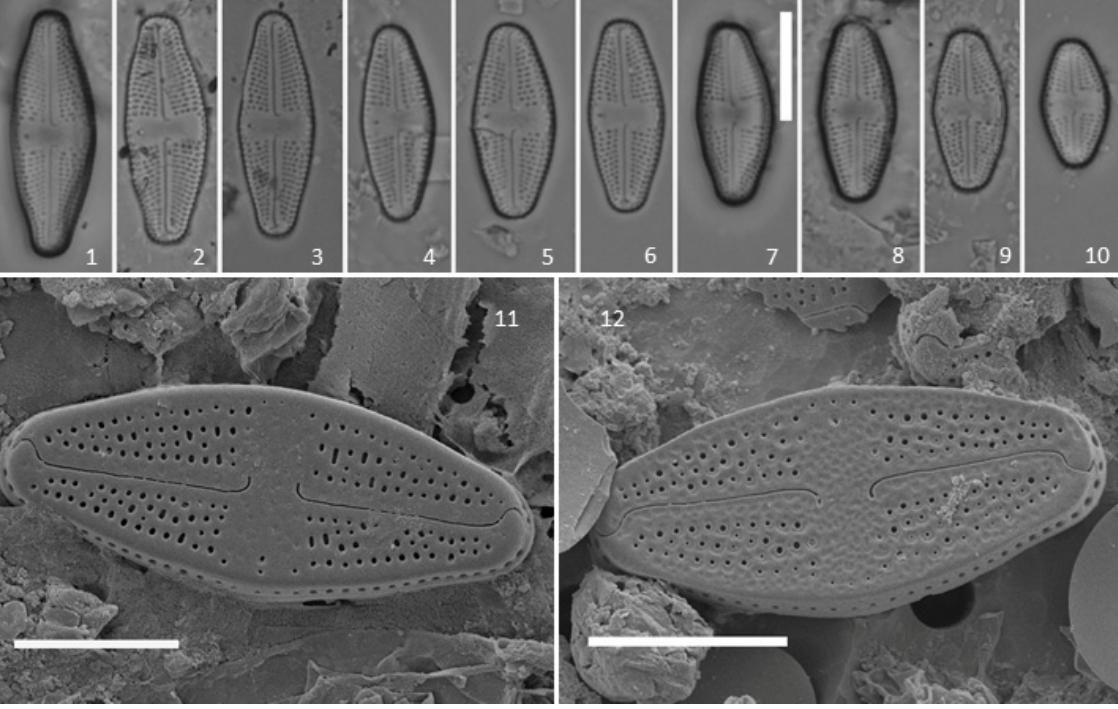
Figs 1–12. Luticola beyensii Van de Vijver et al. Light (LM) and scanning electron micrographs (SEM) of a population from Ile Amsterdam. 1–10 . LM of valve face views. 11–12 . SEM of external view of entire valve, showing raphe structure, position of the isolated pore and striae structure. Scale bars: 1–10 = 10 µm; 11–12 = 5